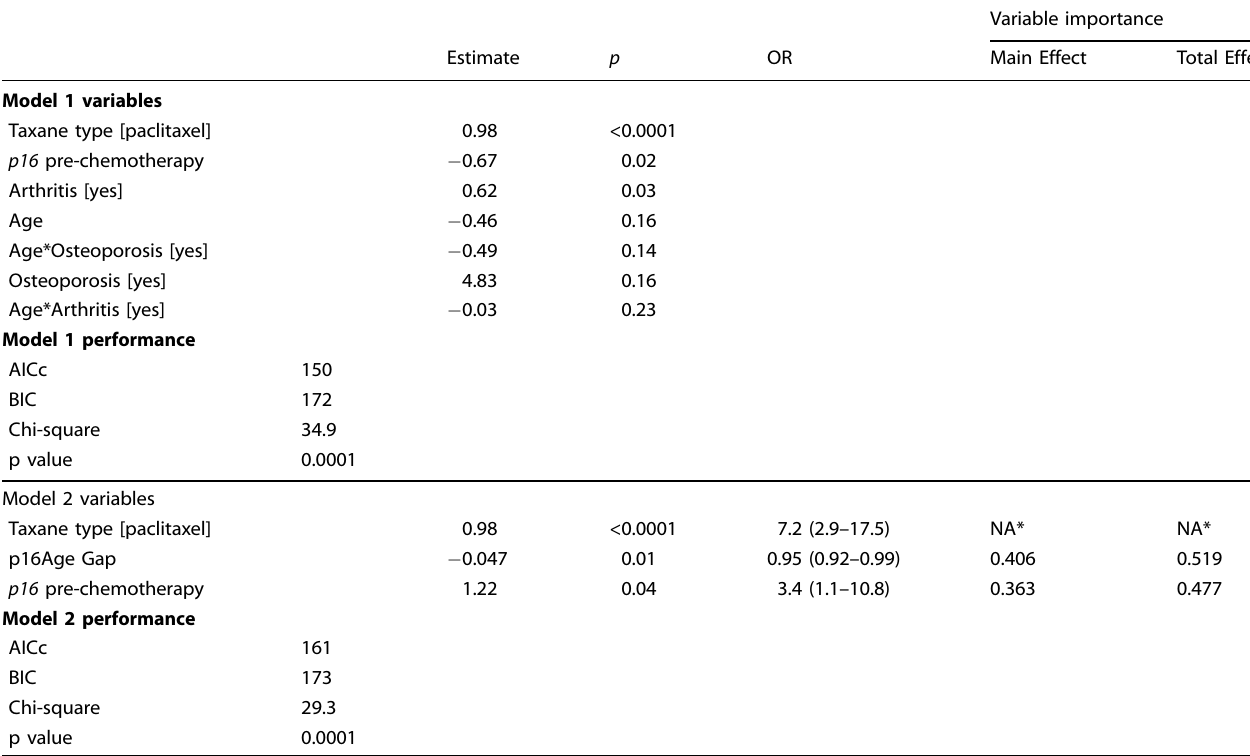
Table 2. Performance and optimal variable combinations produced by multivariate regression analysis to predict risk of grade 2 +